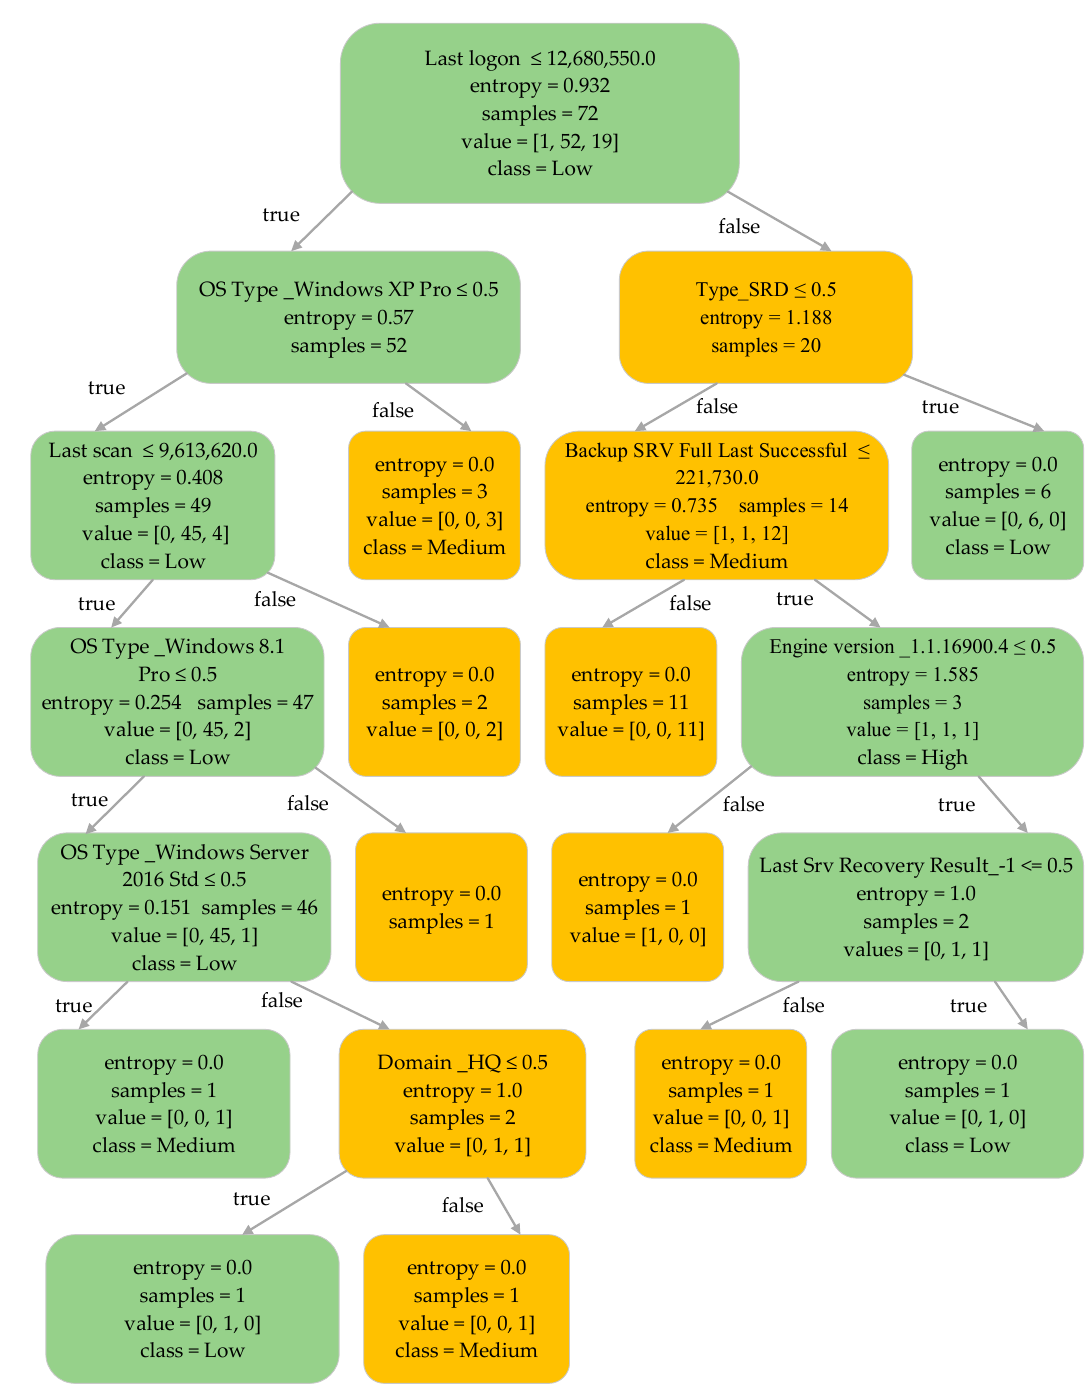
Figure 9. Results visualization of building a decision tree.